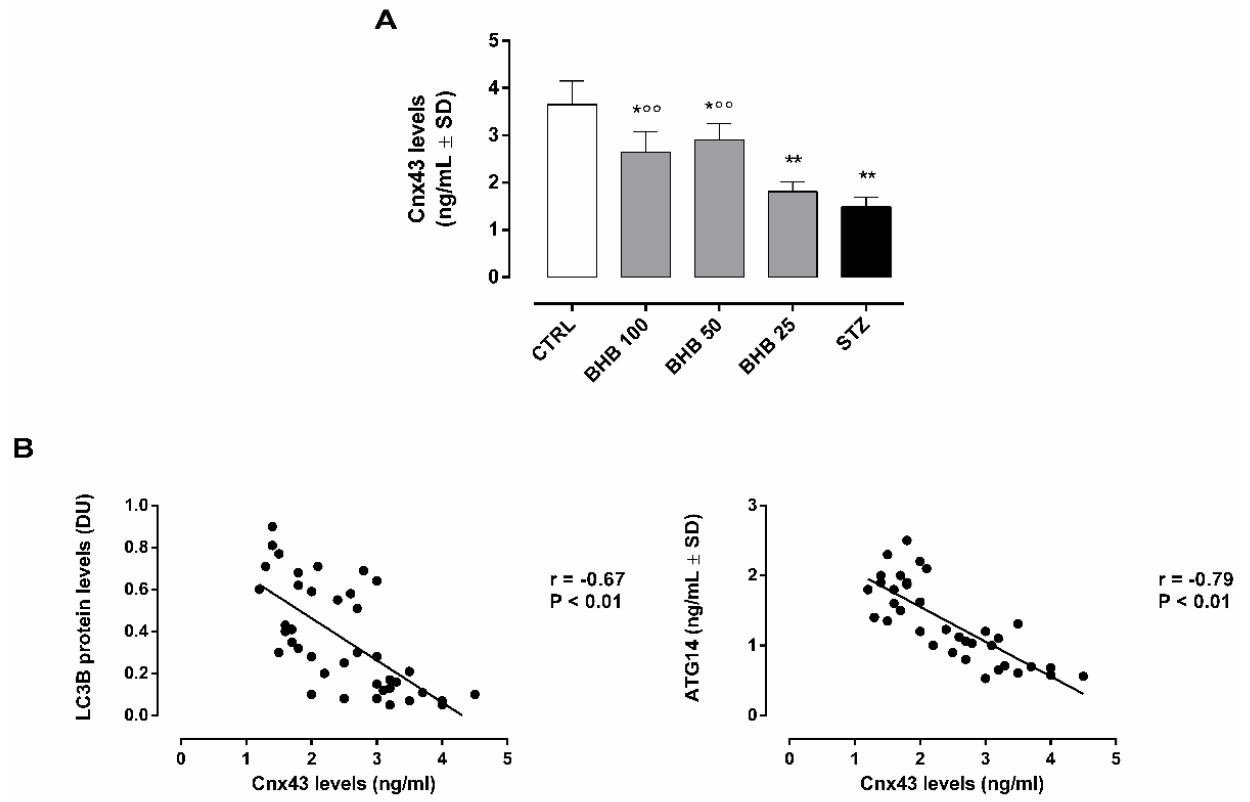
Figure 3. Retinal Cnx43 levels ( A ) and their strength of association with LC3B and ATG14 ( B ) in non-diabetic mice (CTRL), diabetic mice (STZ), and diabetic mice treated with BHB 25 mg/kg (BHB 25), 50 mg/kg (BHB 50), and 100 mg/kg (BHB 100). Cnx43 levels (ng/mL) are expressed as mean ± SD of N = 8 retinas per group. * p < 0.05 and ** p < 0.01 vs. CTRL; °° p < 0.01 vs. STZ.